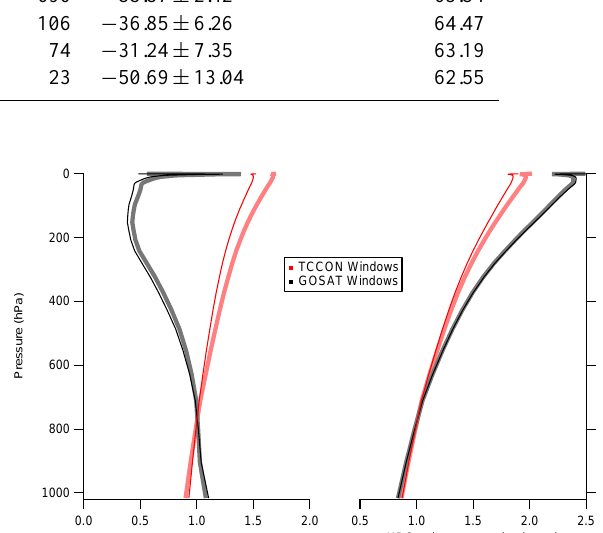
Fig. 6. Spectral fit of the GOSAT HDO/H 2 O retrieval over Orleans, France on 31 July 2010.